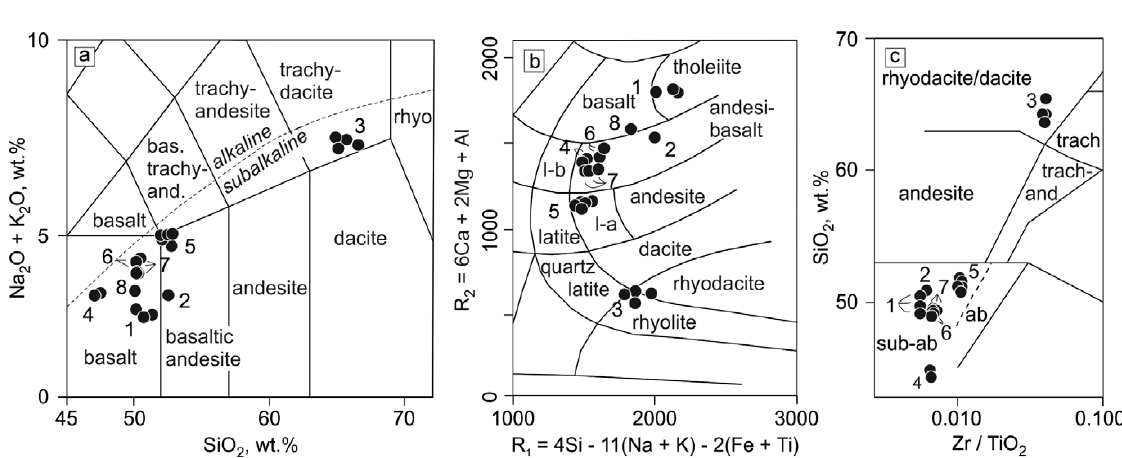
Figure 4 - Chemical classification of the eight lava flows from the Entre Rios mining district, based on (a) Na (Le Bas et al. 1986), (b) R1 x R2 (De La Roche et al. 1980), (c) zr/TiO indicated by number (e.g. 4). Abbreviations: bas. trachy-and. = basaltic trachyandesite, rhyo = rhyolite, l-b = lati-basalt, l-a = lati-andesite, trach = trachyte, trach-and = trachy-andesite, ab = alkaline basalt, sub-ab = subalkaline